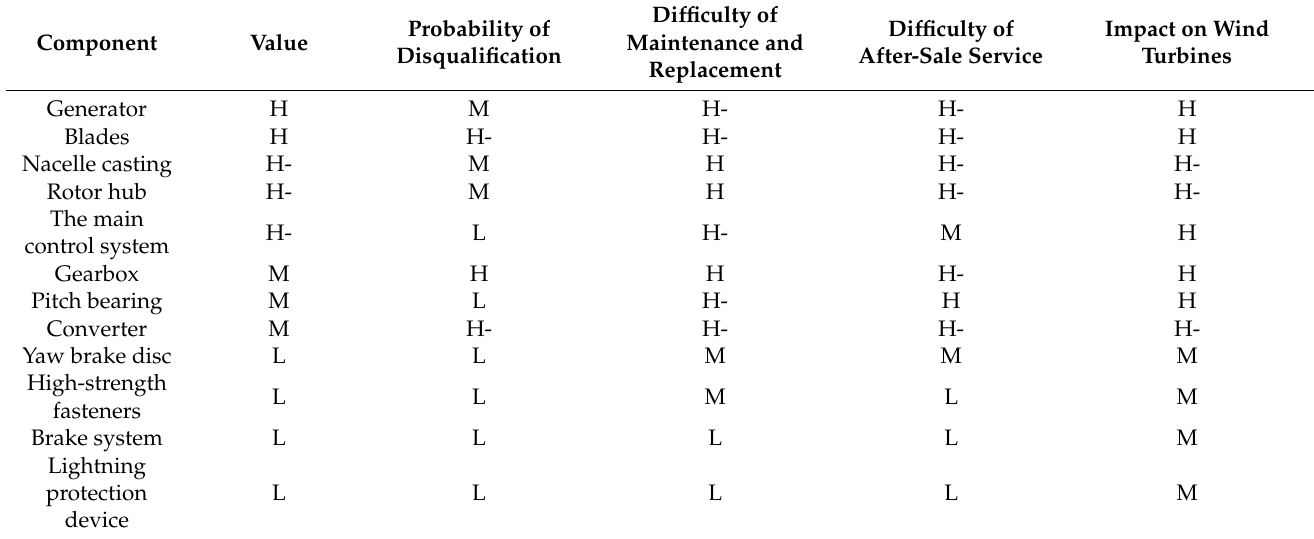
Table 1. Analysis of the key components of a wind